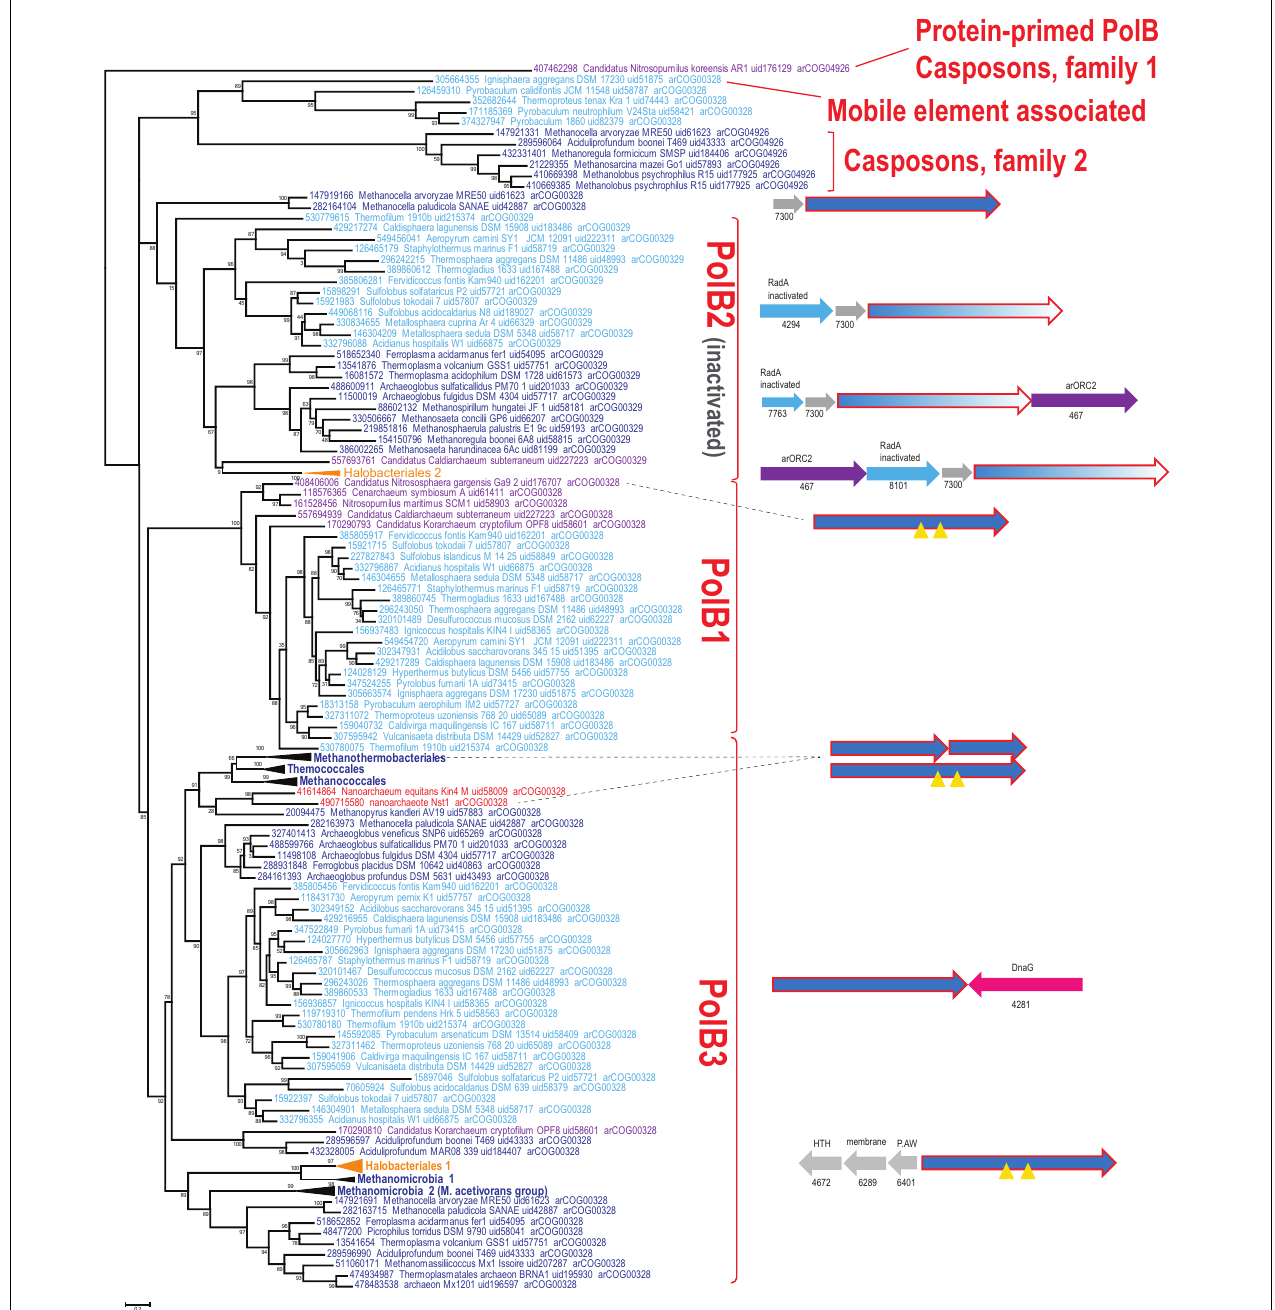
FIGURE 1 | Phylogenetic analysis of the polymerase B family in archaea. The MUSCLE program (Edgar, 2004) was used for construction of sequence alignments. The tree was reconstructed using the FastTree program (Price et al., 2010) (179 sequences and 209 aligned positions). The complete tree is available in the Supplementary Figure S3. The sequences are denoted by their GI numbers, species names, refseq genome UID number and the arCOG number to which the respective protein currently assigned. Several branches are collapsed and shown as triangles denoted by the respective lineage taxonomy name. Color code: Euryarchaeota, dark blue, with the exception of Halobacteria that are shown in orange; Crenarchaeota, light blue; deeply branched archaeal